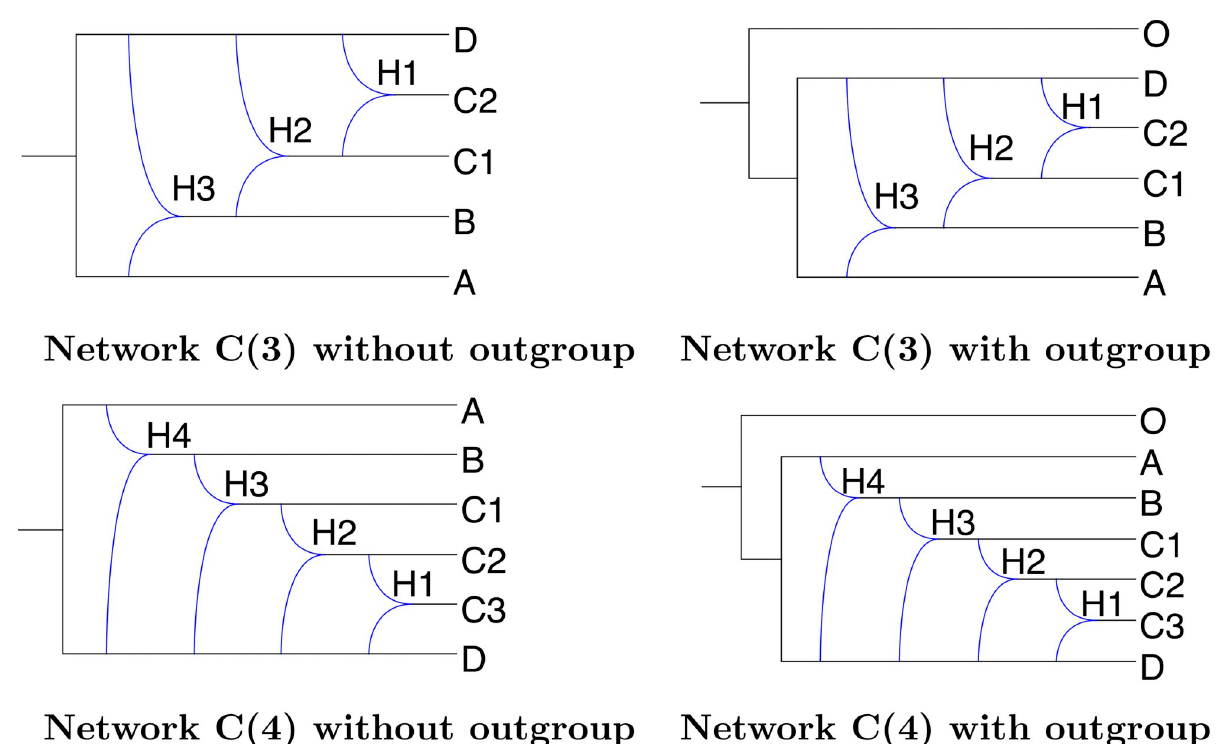
Fig 8. The networks from the C family, with either 3 or 4 reticulation nodes, and with or without outgroup O.